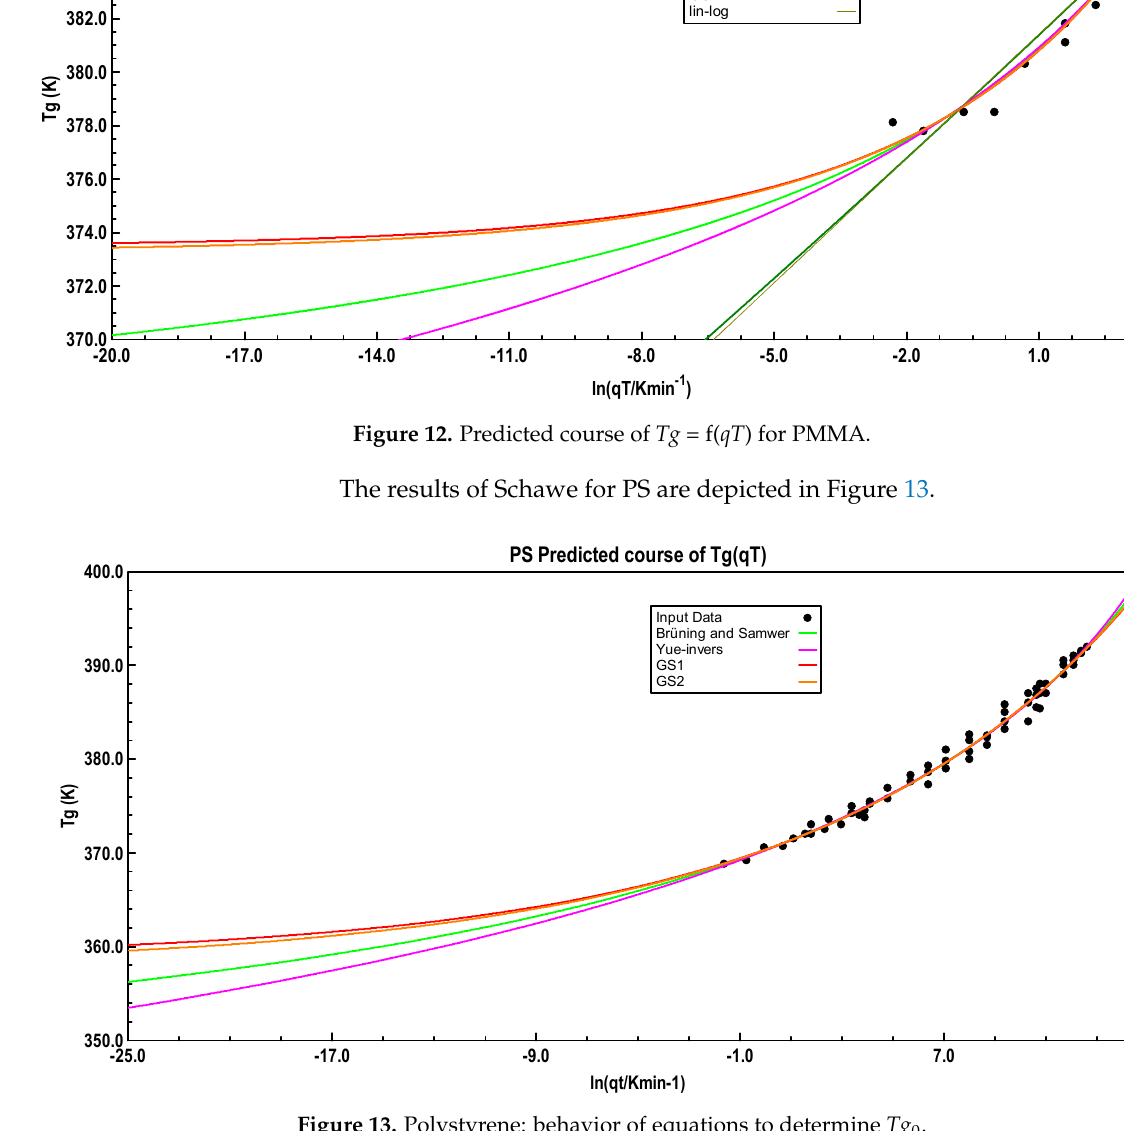
Figure 13. Polystyrene: behavior of equations to determine Tg 0.